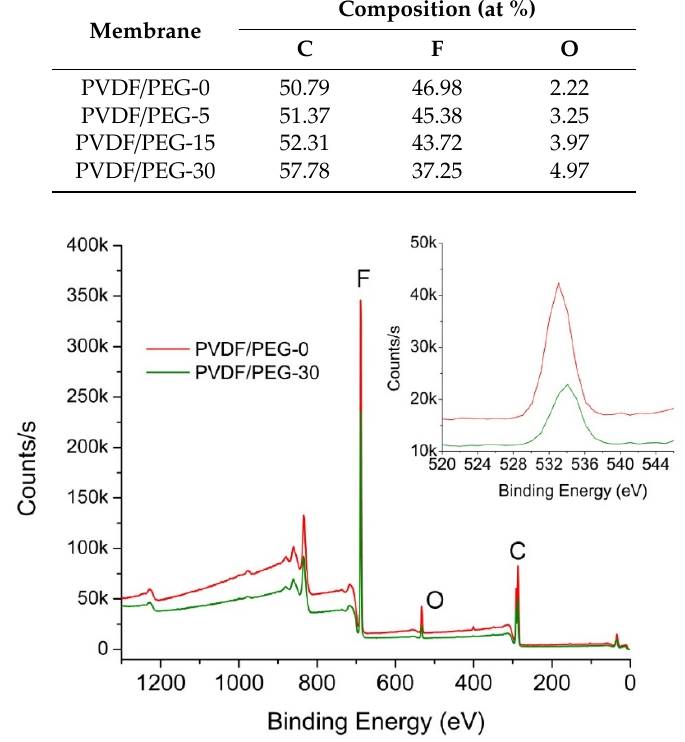
Table 1. Chemical composition distribution of the PVDF membrane and modified membranes by EDX. Membrane